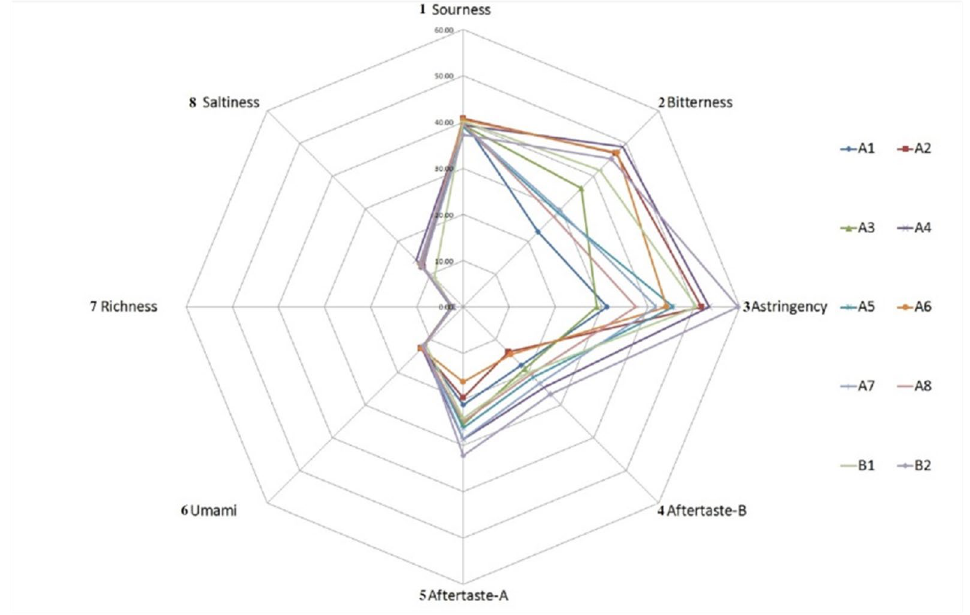
Figure 5. Radar chart of E-tongue data for beef bouillons.